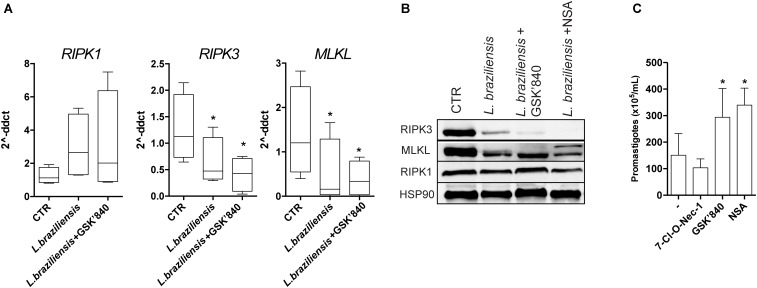
RIPK3-, but not RIPK1-mediated necroptosis, restrains Leishmania growth inside macrophages. PMA-differentiated THP-1 cells were pretreated with the indicated inhibitors for 1 h, followed by infection with L. braziliensis for 24 h. (A) RIPK1, RIPK3, and MLKL from macrophages was determined by real-time PCR. (B) RIPK1, RIPK3, and MLKL protein expression was determined by Western blot. HSP90 was used as a loading control. (C) PMA-differentiated THP-1 cells were pretreated with the indicated inhibitors for 1 h, followed by infection with L. braziliensis. The parasite load was measured by the counting of viable promastigotes as described in the Section “Patients and Methods.” Lines and boxes represent medians and interquartile ranges, and whiskers represent minimum and maximum values. Three independent experiments were performed. Values were compared by the Kruskal–Wallis test with Dunn’s multiple comparisons post-test. ∗P < 0.05.